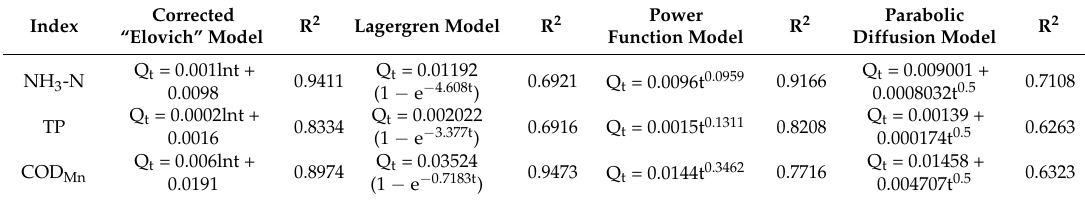
Table 7. Fitting results of adsorption kinetic model, Q t : adsorption quantity (mg/g), t: time (h).